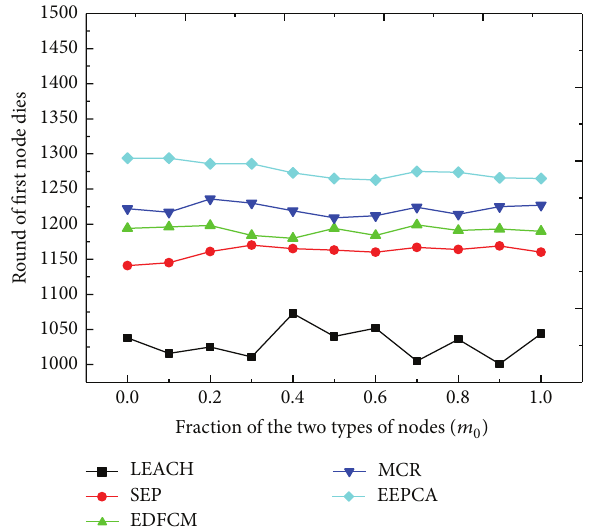
Figure 6: Round of first node dies with varying number of sensor nodes.